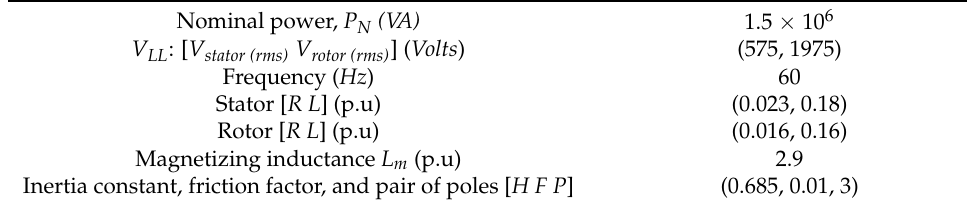
Table A3. Generator data.